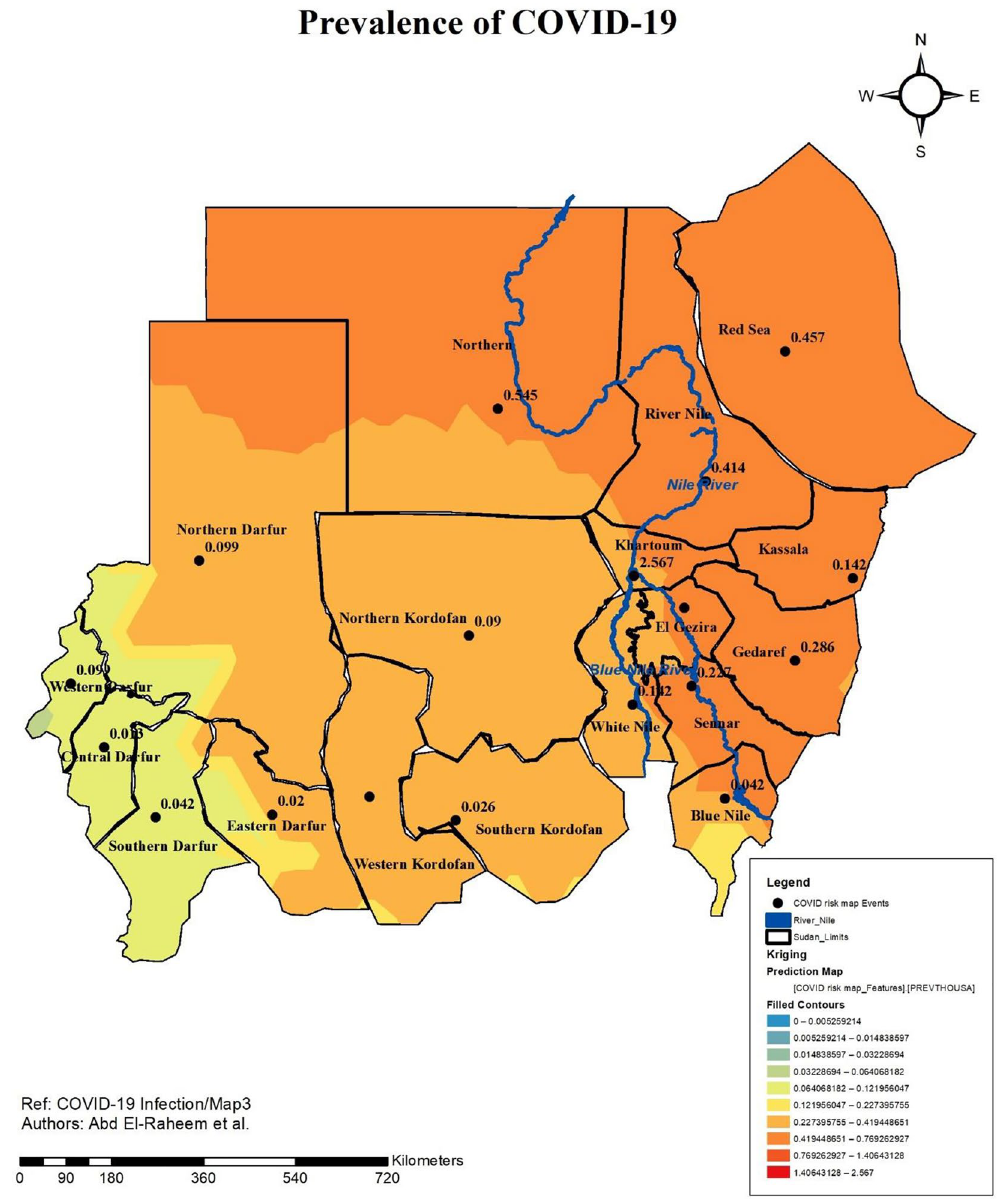
Figure 5. Risk Map of COVID-19 Infection in Sudan developed through ArcGIS 10.8 by Abd El-Raheem et al. (Shp. files of the base maps https:// www. diva- gis. org/